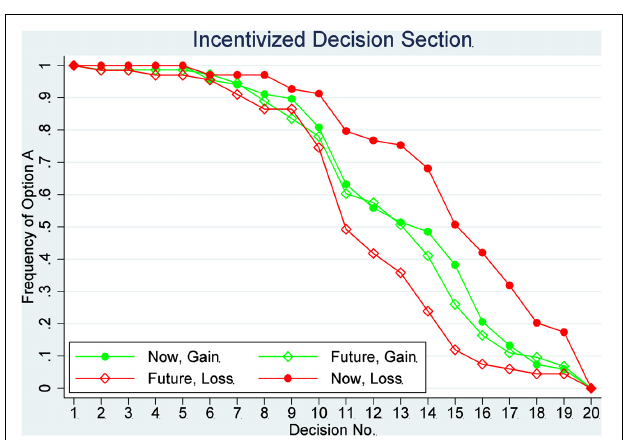
FIGURE 2 | Proportion of safe choices in each decision: the incentivized decision section.